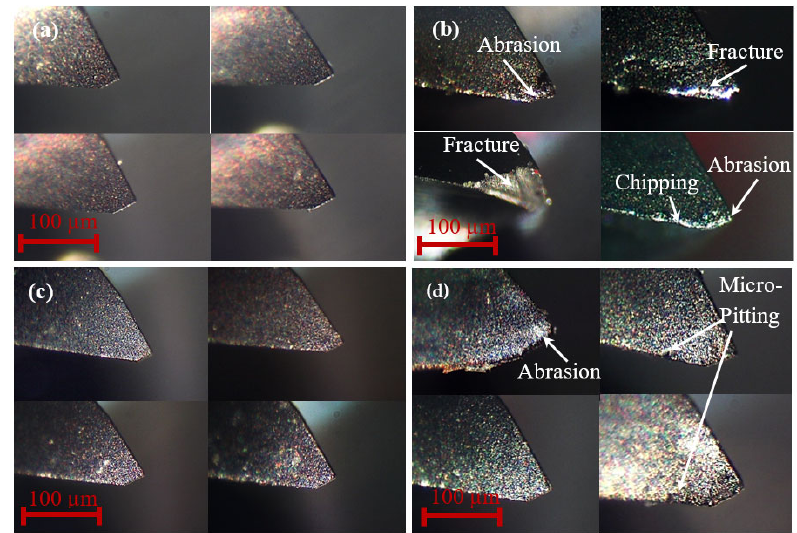
Figure 10. Optical micrographs of the flank wear evolution of 4-flute tool with conventional fluid ( a ) after one run, ( b ) after 20 runs, and with water-soluble sago starch cutting fluid ( c ) after one run, ( d ) after 20 runs.